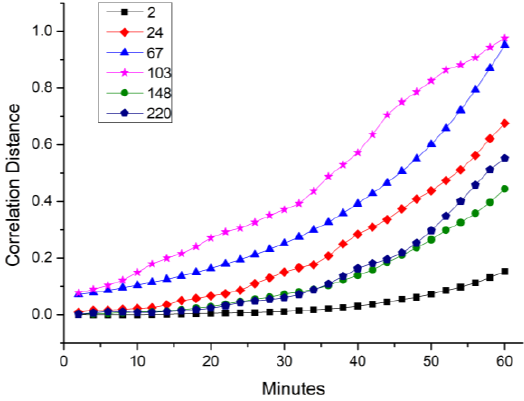
Figure 6. Trend of correlation distance along with the time lag.